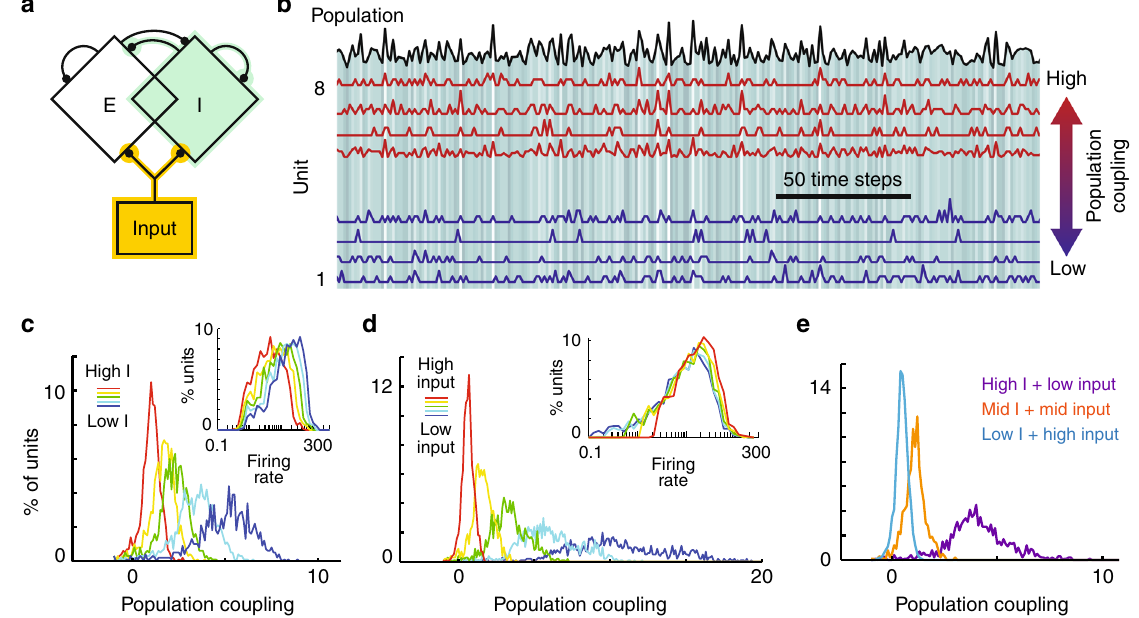
Fig. 3 Weak external input entails strong population coupling. a Schematic of a model network of 1000 binary excitatory (E) and inhibitory (I) neurons driven by external input. Two components of the model change due to altering inhibition: local inhibitory input (green) and the strength of external input to the network (yellow). b Spike count time series from eight model neurons with high (red) and low (blue) population coupling. The black line and background grayscale indicates the population spike rate. c Holding external input fi xed, the mean and variance of population coupling decreases as local inhibition is increased. This scenario is inconsistent with our experiments. Firing rates increase as local inhibition is decreased (inset), also inconsistent with our experiments. d Holding local inhibition fi xed, the mean and variance of population coupling decreases as input increases. Firing rates remain relatively unchanged (inset). e A combination of increased local inhibition and decreased external input (purple) can match the experimentally observed increases